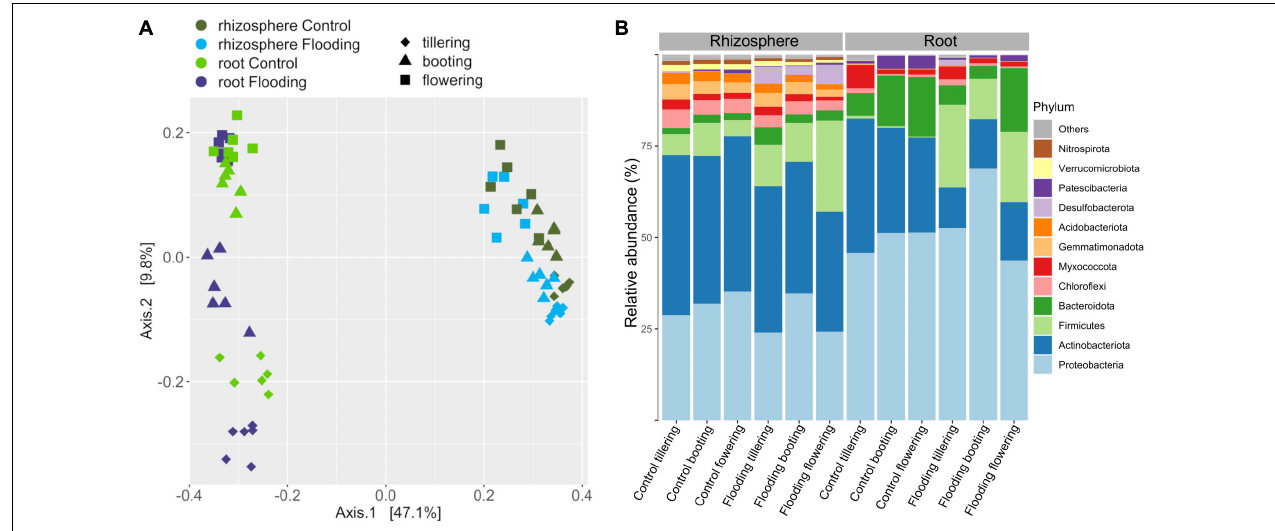
FIGURE 2 | Principal coordinates analysis (PCoA) Bray-Curtis dissimilarity metrics (A) and mean relative abundance of the main phyla (B) of the bacterial communities detected in this study.